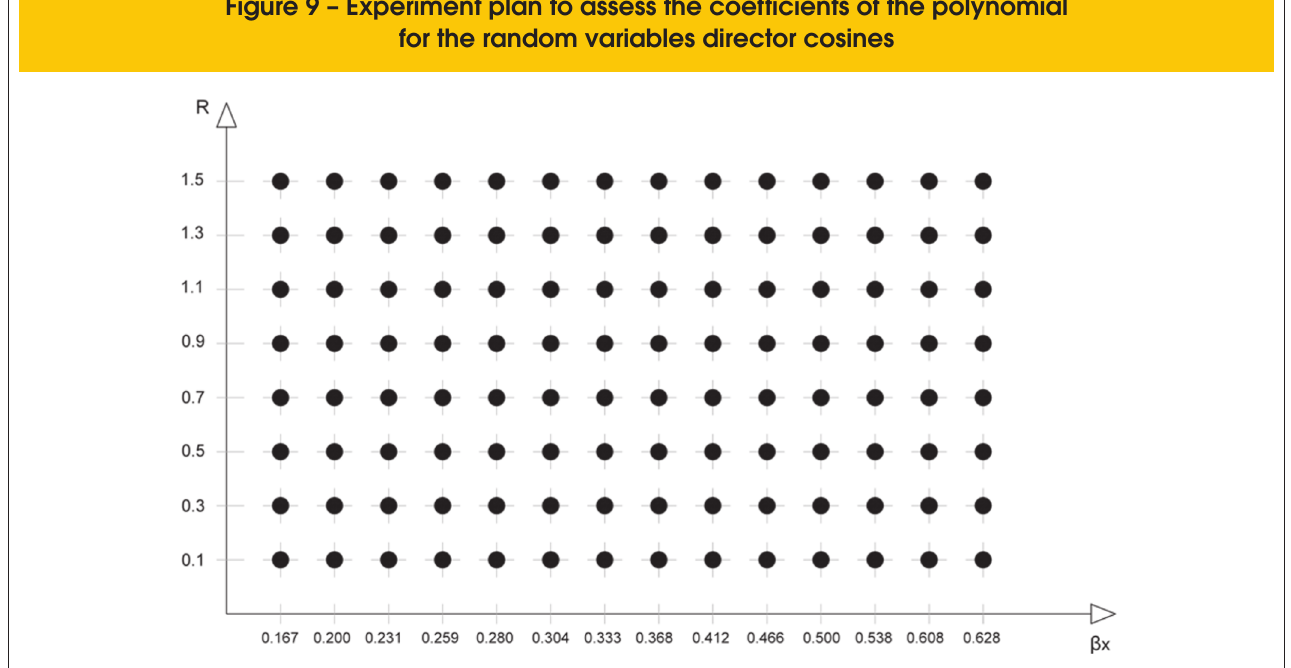
Figure 9 – Experiment plan to assess the coefficients of the polynomial for the random variables director